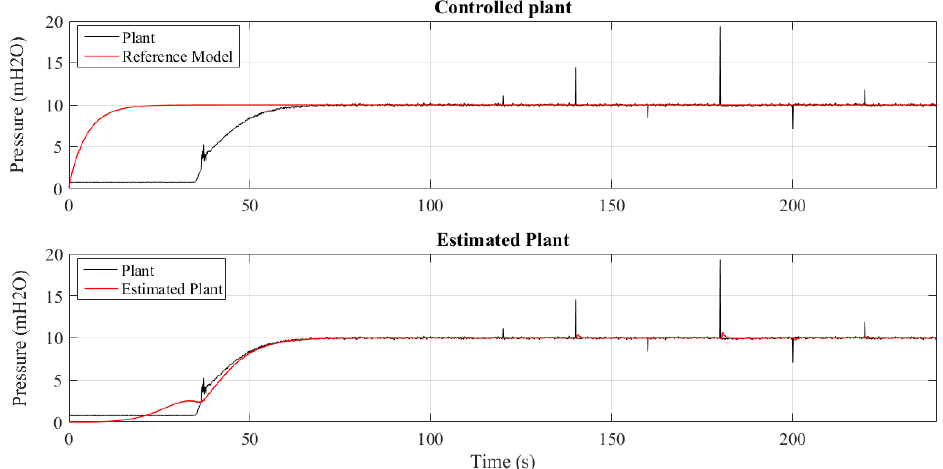
Figure 13. System controlled using MCC criterion subjected to outliers every 20 s.